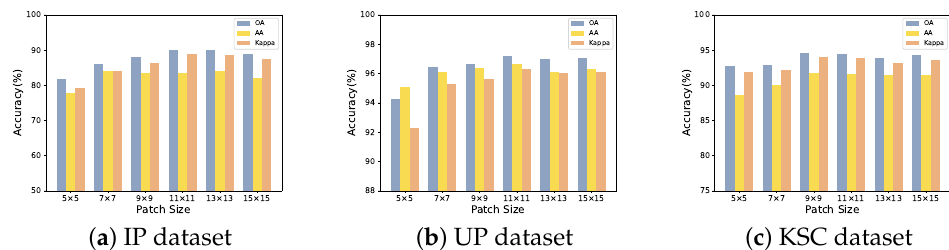
Figure 6. The classification results of the proposed AETF-Net with different patch